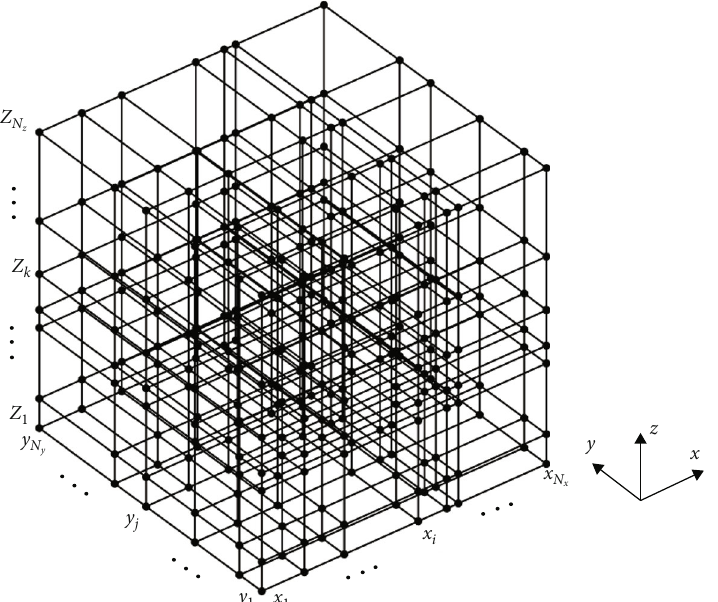
Figure 1: Three-dimensional nonuniform mesh.